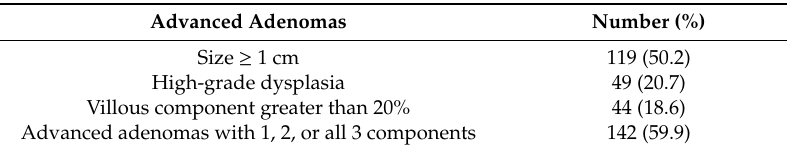
Table 5. Advanced adenomas.